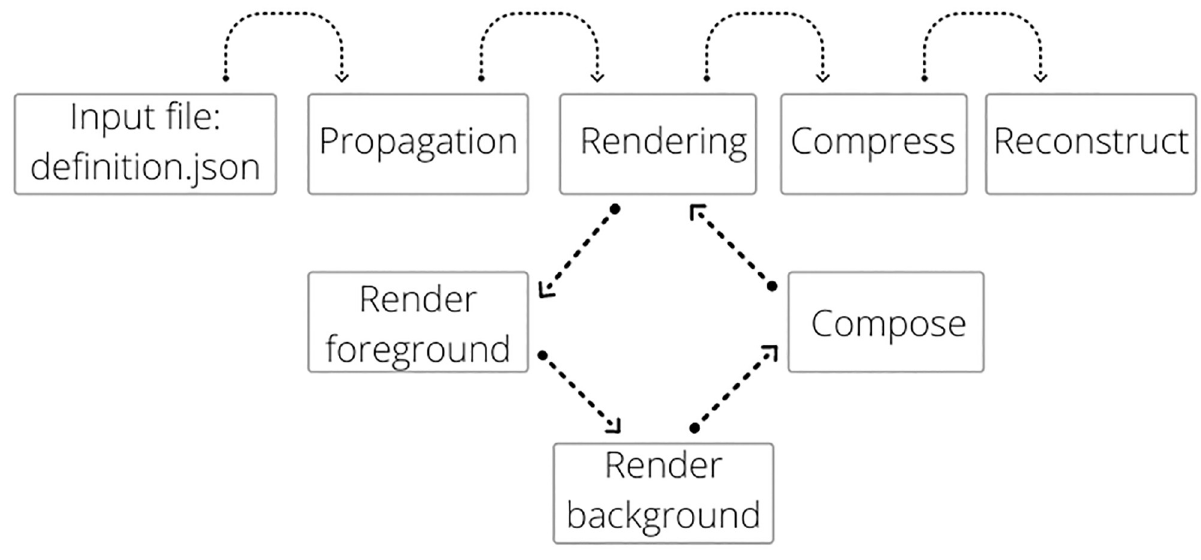
Fig 2. Program flow of